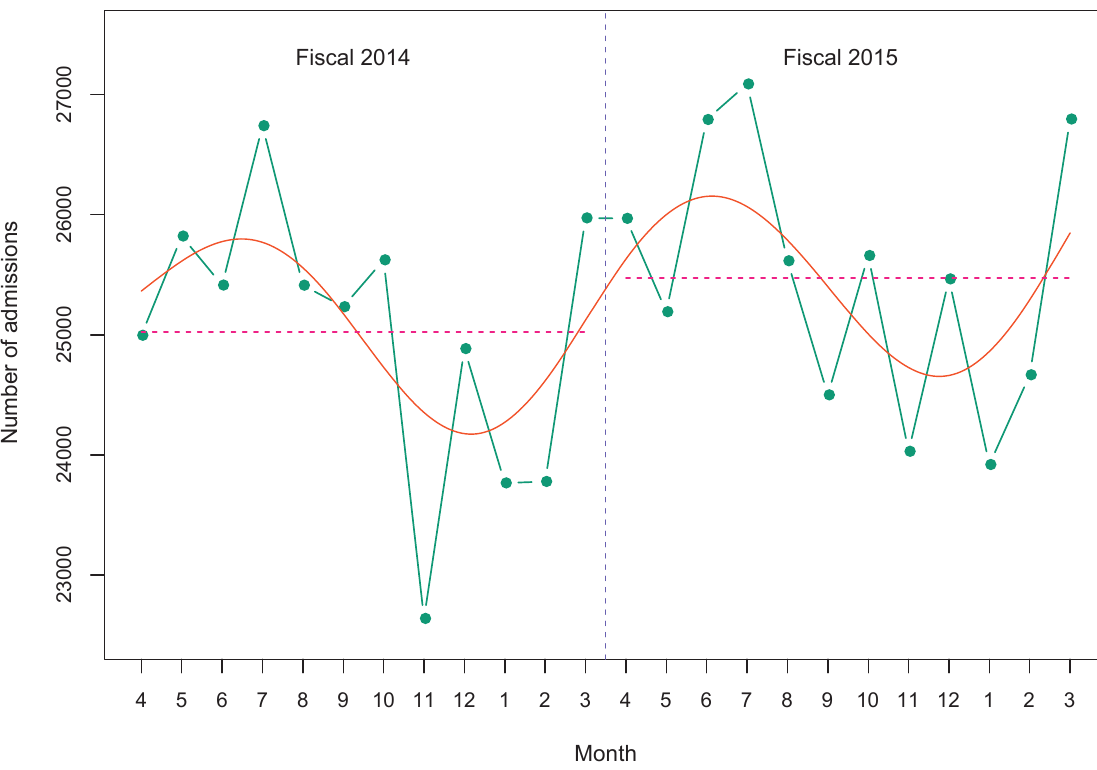
Figure 1. Number of new psychiatric admissions by